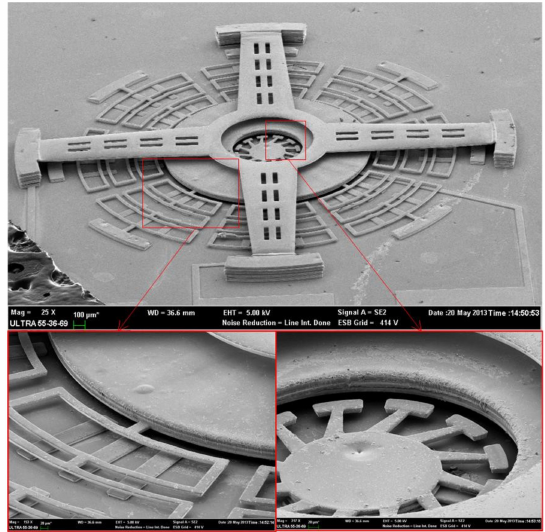
Figure 7. SEM photos of the prototype.